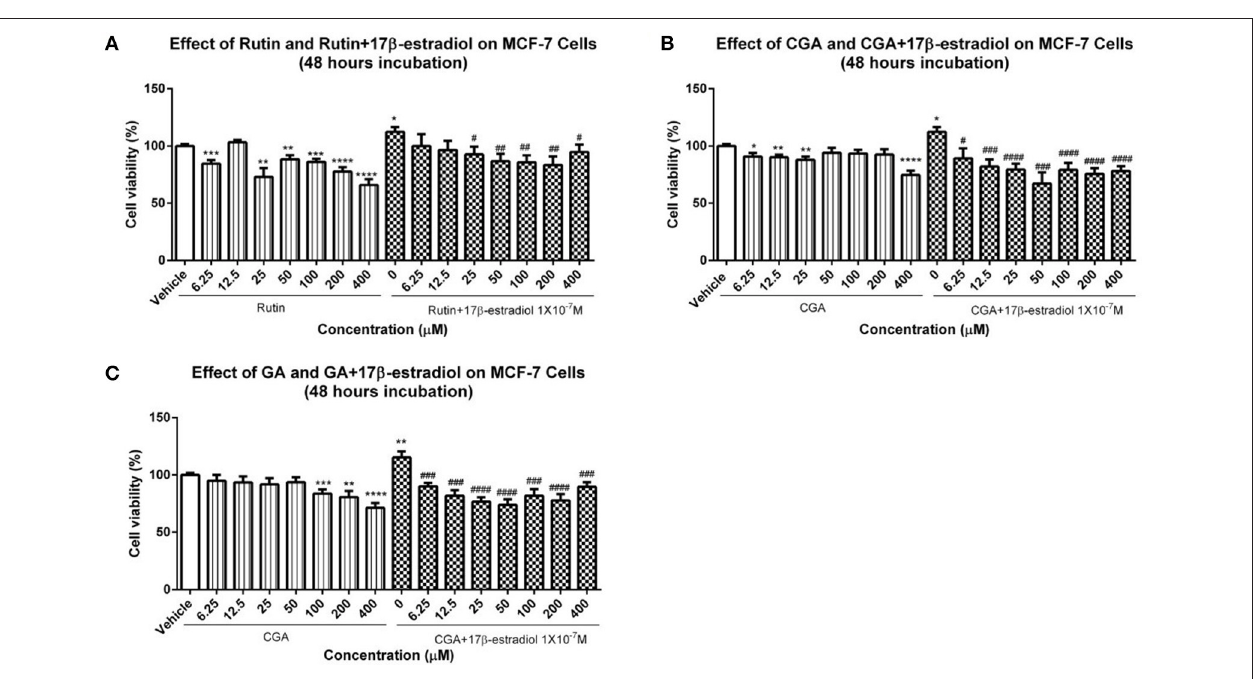
FIGURE 13 | Viability of MCF-7 breast cancer cells. (A–C) The proliferation of MCF-7 cells in the presence or absence of 1 × 10 − 7 M 17 β -estradiol was determined by using MTT assay after 12h treatment with different dosages of rutin, CGA, and GA. Each value represented mean ± SEM ( n = 4), * p < 0.05, ** p < 0.01, *** p < 0.001, **** p < 0.0001, vs. vehicle control group; # p < 0.05, ### p < 0.01, ### p < 0.001, #### p < 0.0001 vs. 17 β -estradiol